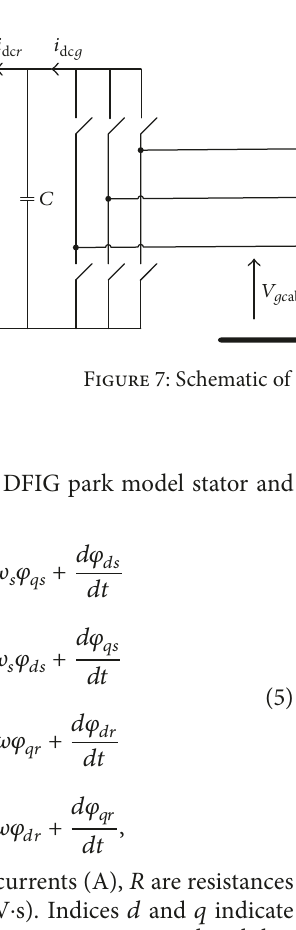
Figure 6: DFIG equivalent circuit in 𝑑 - 𝑞 reference frame [10].